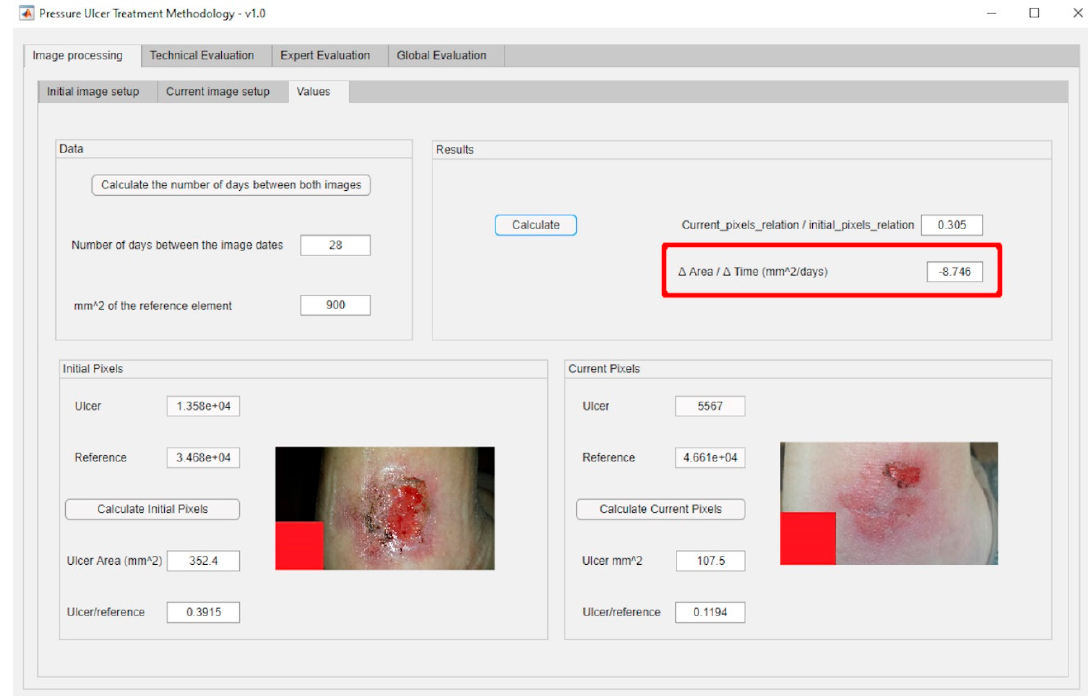
Figure 4. Dialog box showing the values obtained from the processing of the images.